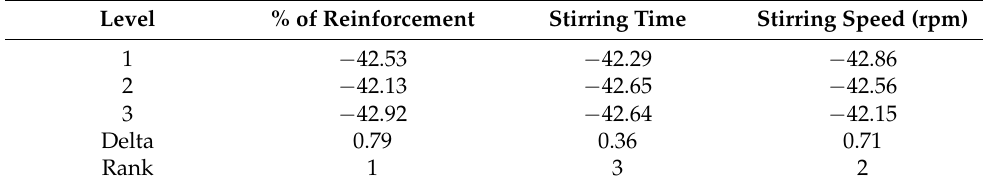
Table 12. Response table for signal to noise ratios (wear). Smaller is